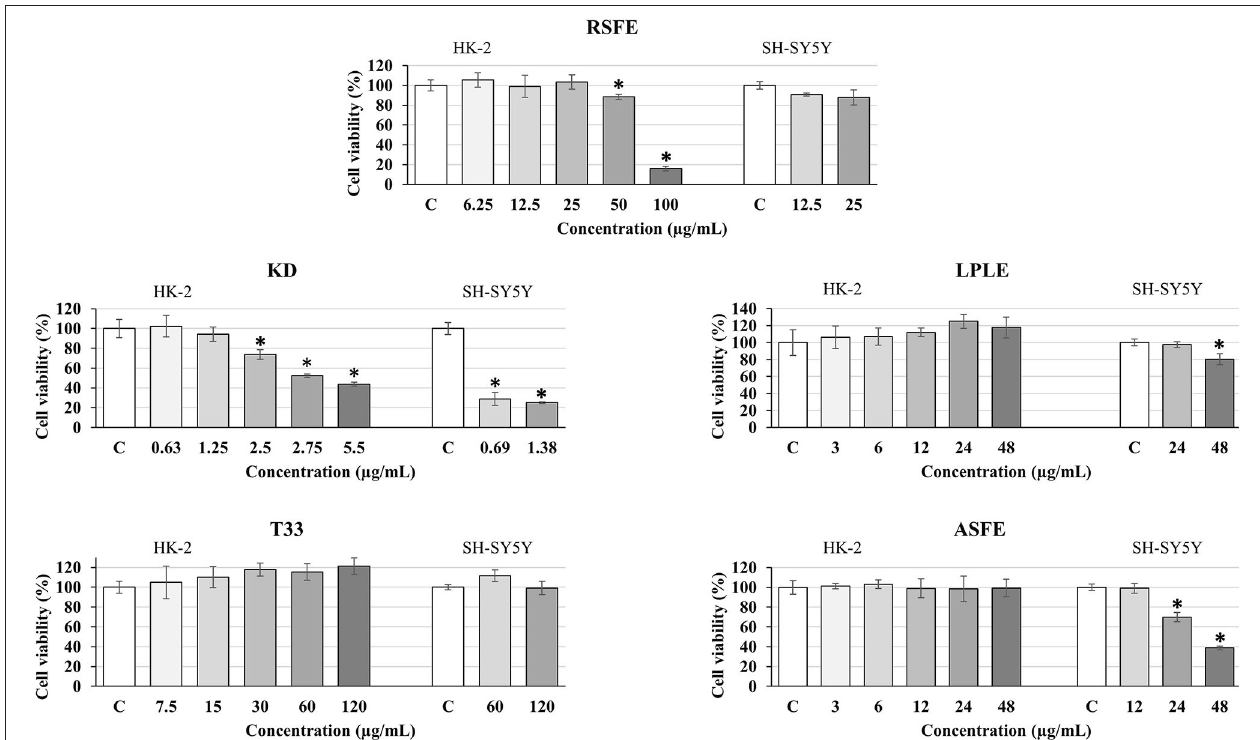
FIGURE 5 | Effect of different concentrations of extracts: RSFE ( Rosmarinus officinalis L., SFE extract), KD ( Kalanchoe daigremontiana , kalanchoe UAE extract), LPLE ( Nothofagus pumilio , lenga PLE extract), T33 ( Cyphomandra betacea , tamarillo PLE extract), and ASFE ( Robinia pseudoacacia , acacia SFE extract) on cell viability in HK-2 (human proximal tubular epithelial cells) and differentiated SH-SY5Y human neuroblastoma cells. Each bar is the mean of three determinations ± SD. * Denotes statistical differences when compared to the percentage of living cells in extract-treated cells with control (EtOH-treated cells which were considered as 100%). (* p < 0.05; ANOVA test, mean values from experimental results were compared by Tukey’s HSD